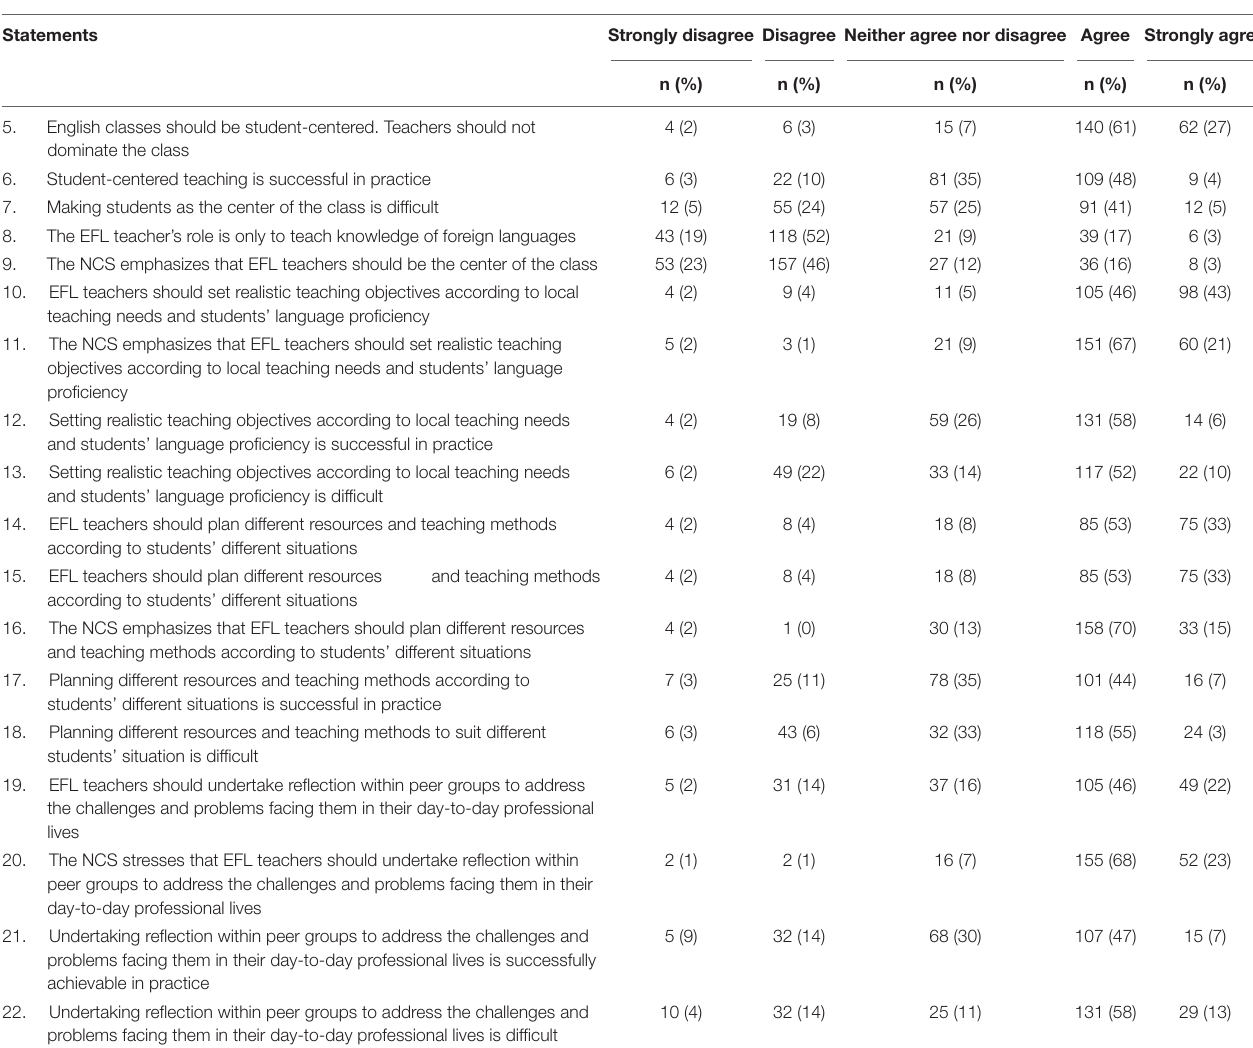
TABLE 2 | Teachers’ responses to statements about teacher